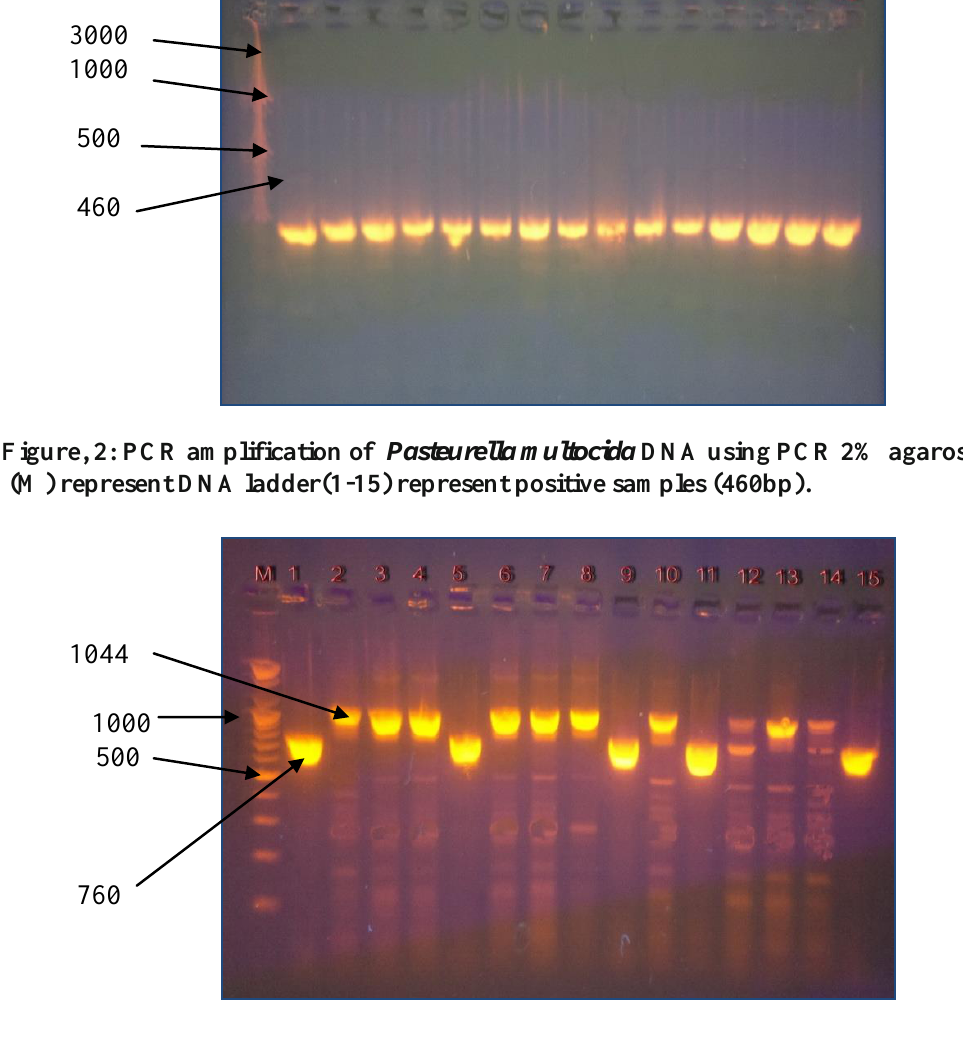
Figure, 3: Multiplex capsular PCR assay on Pasteurella multocida isolates representing the two types (A, B) of isolates detected (M) represent ladder DNA (2,3,4,6,7,8,10,13) represent type A (1044 bp) (1,5,9,11,15) represent type B (760